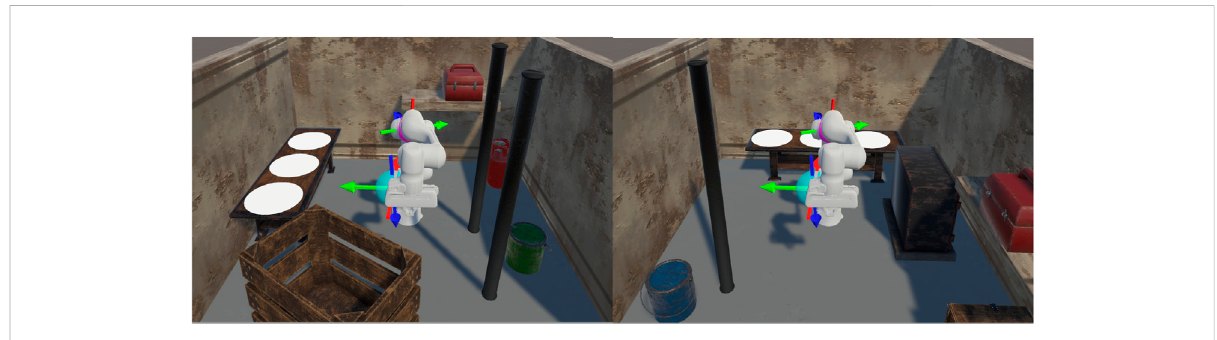
FIGURE 4 The two experimental scenes. The robot control targets are the coloured spheres, one for the end effector in cyan, and one just visible at the “ elbow ” in